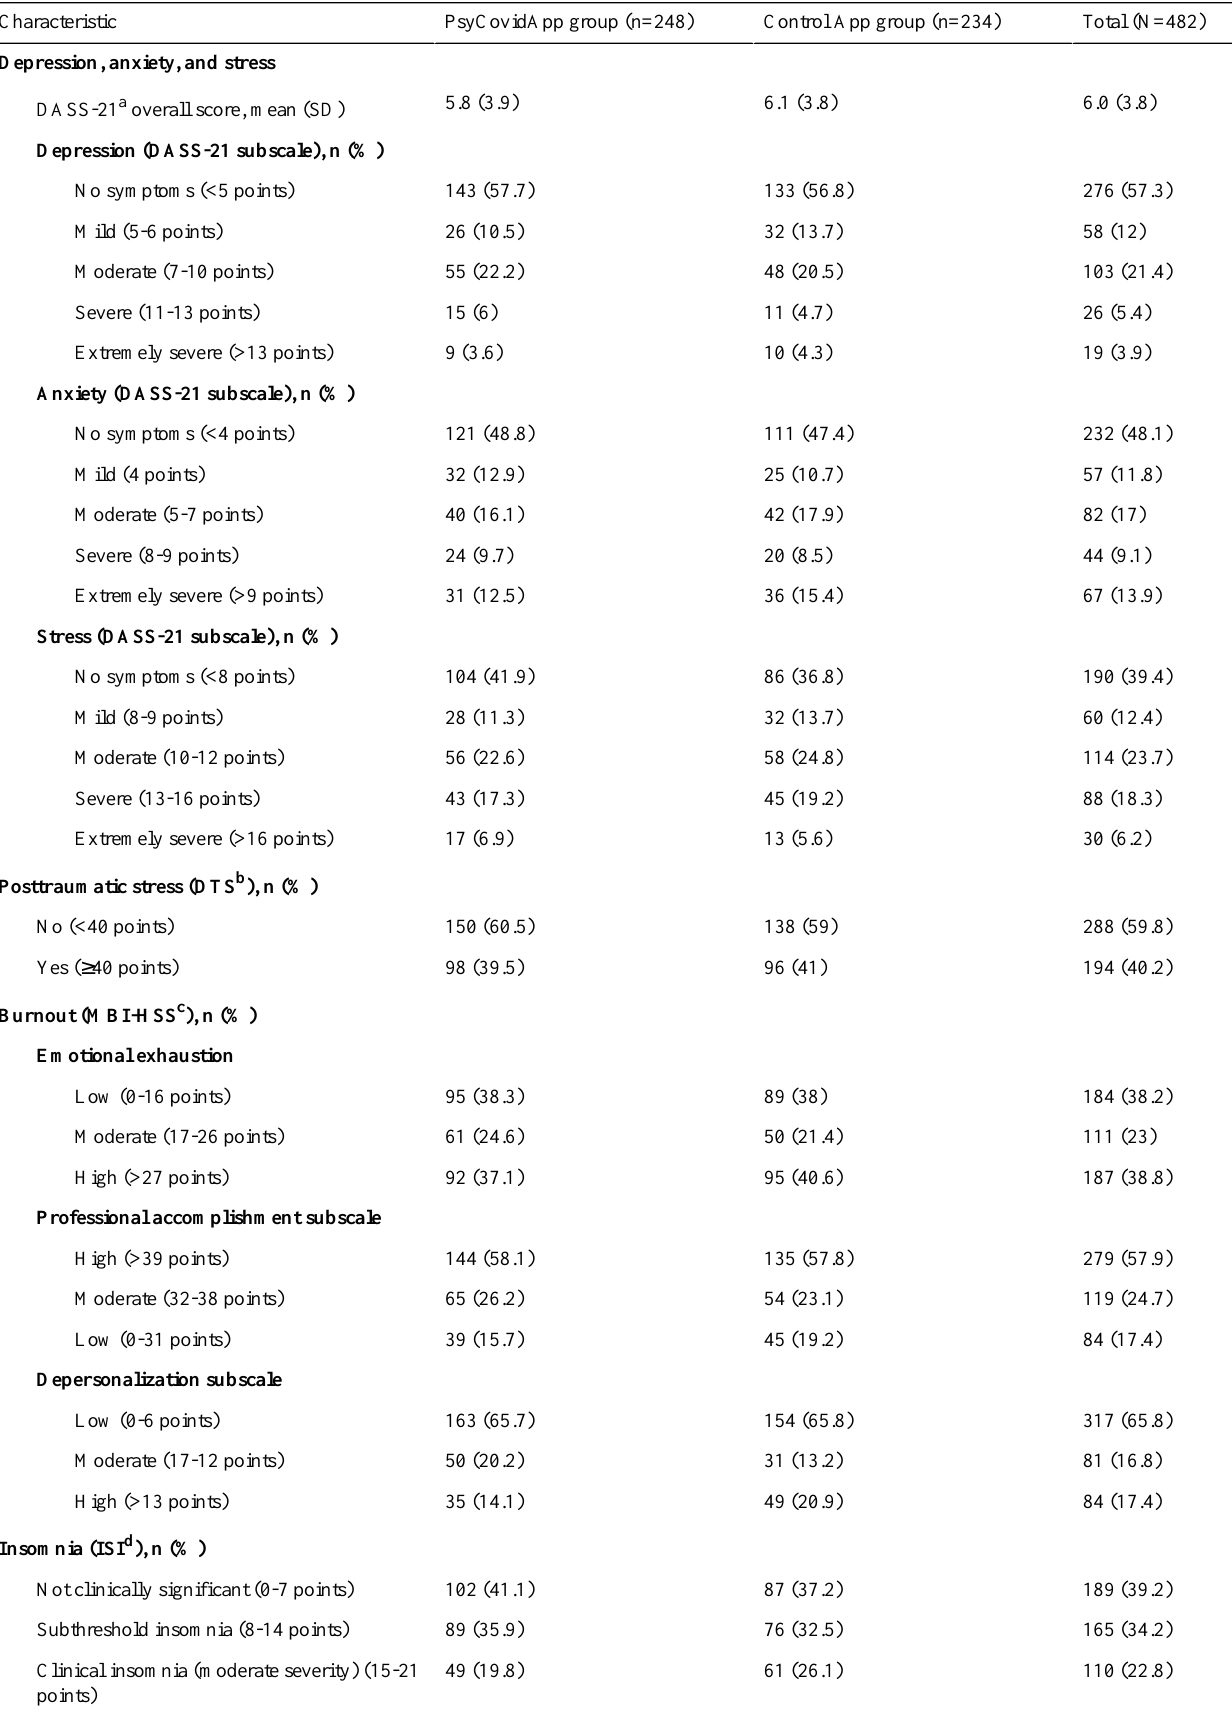
Table 2. Baseline clinical characteristics of the intention-to-treat population (N=482).